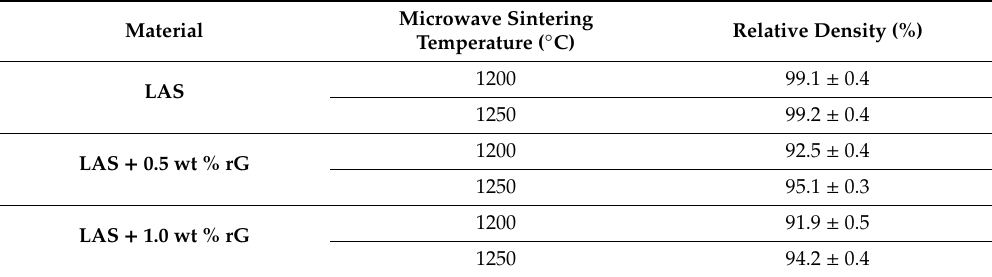
Table 2. Microwave sintering temperatures and relative density of di ff erent